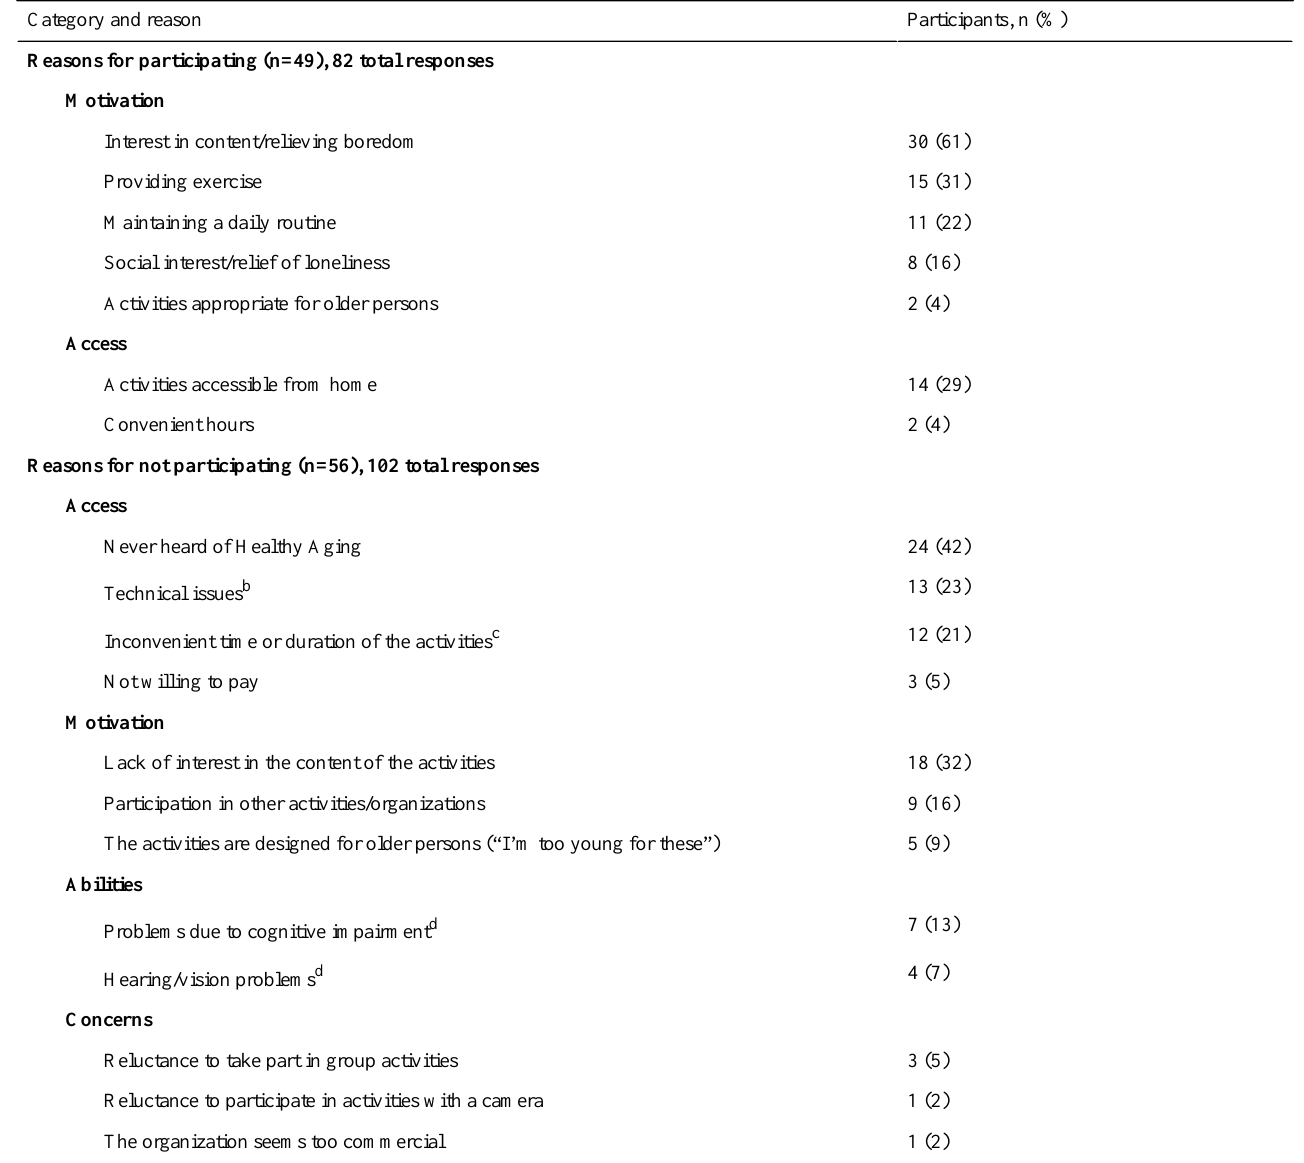
Table 2. Study participants’reasons for participating (n=49) and not participating (n=56), n=105.